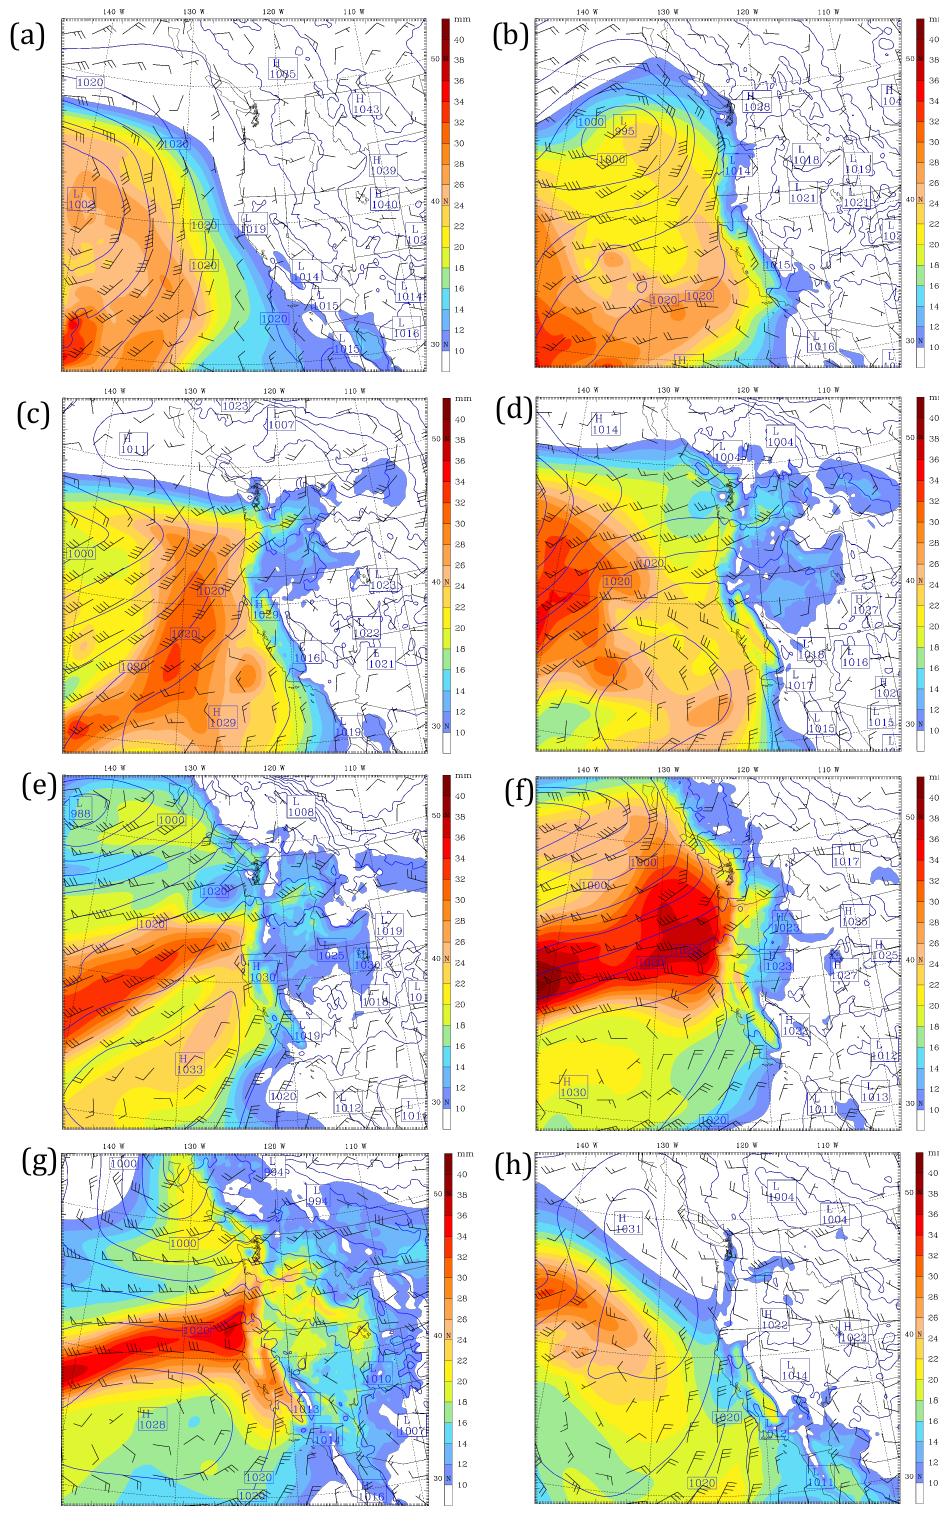
Figure 3. The column-integrated water vapor (shaded;mm), 850hPa wind vector and sea level pressure (contours; hPa) from ECMWF Interim reanalysis at (a) 00:00UTC (16:00 local time) on 11 January, (b) 00:00UTC on 12 January, (c) 00:00UTC on 13 January, (d) 00:00UTC on 14 January, (e) 00:00UTC on 15 January, (f) 00:00UTC on 16 January, (g) 00:00UTC on 17 January and (h) 00:00UTC on 18 January